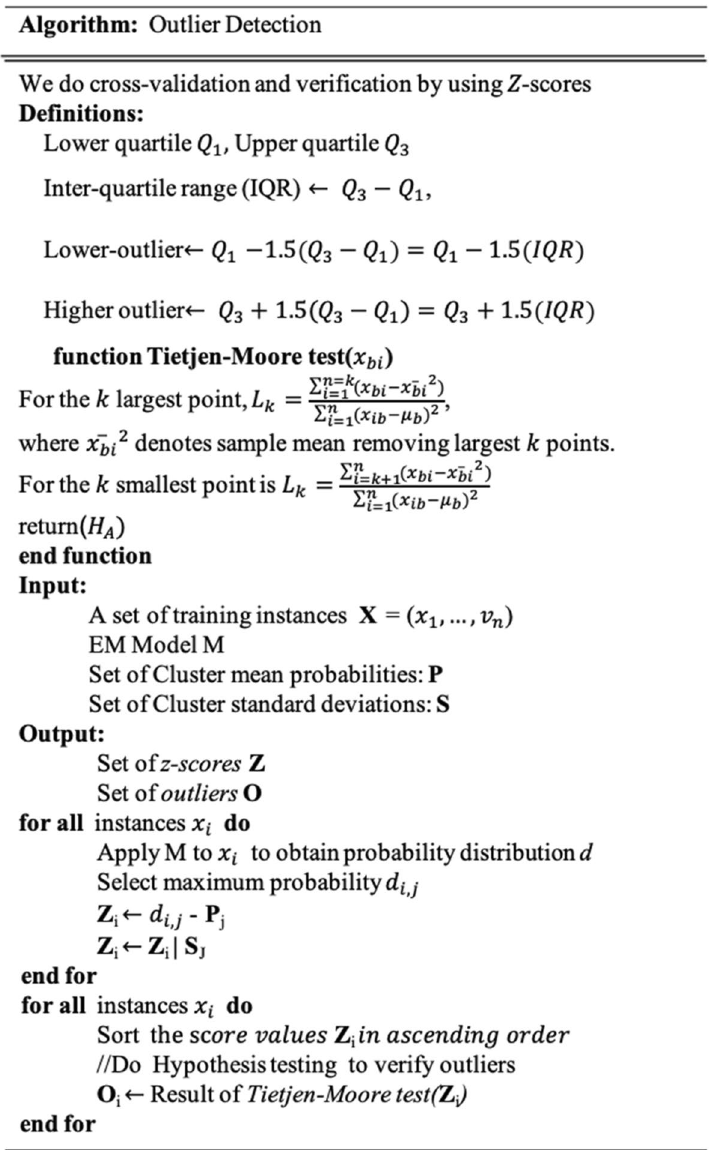
Fig. 15 Outlier detection and validation